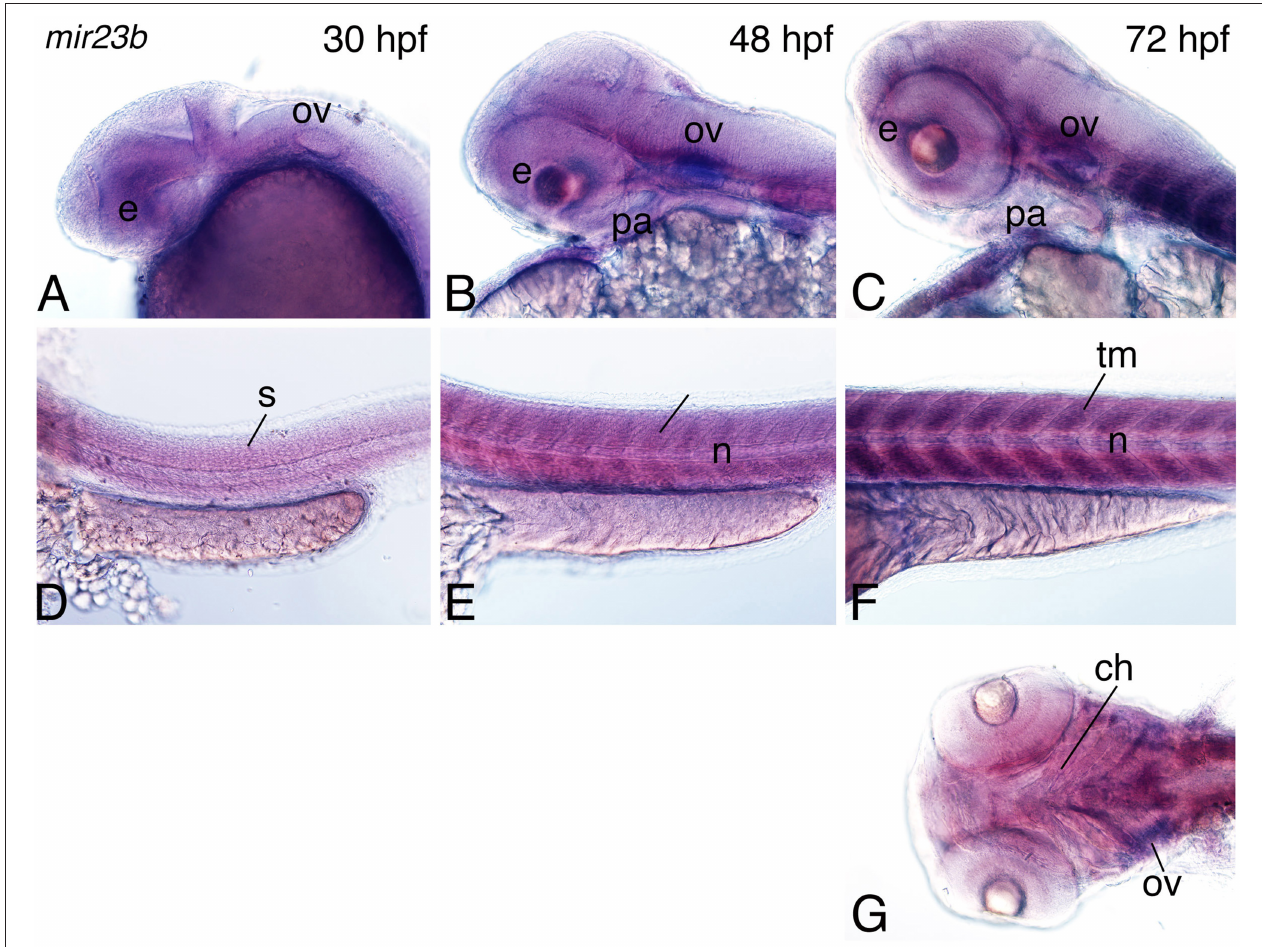
FIGURE 5 | Expression of mir23b in zebrafish embryos. Whole-mount in situ hybridization analysis with a digoxigenin-labeled probe against the mir23b transcript at 30–72hpf. (A–C) Expression is observed in the otic vesicle (ov; A ), weakly in the eye (e), and pharyngeal arch (B,C) , and palate (pl; C ). (D–F) In the trunk, expression is observed in the trunk muscle the somites (s; E,D ) at 30, 48hpf, and trunk muscle (tm; F ) at 72hpf. (G) Ventral view of expression shows more detailed expression in the cranial muscle including the muscles supporting the craniofacial structures (arrows) and the eye. Anterior is to the left. n, notochord; ch,